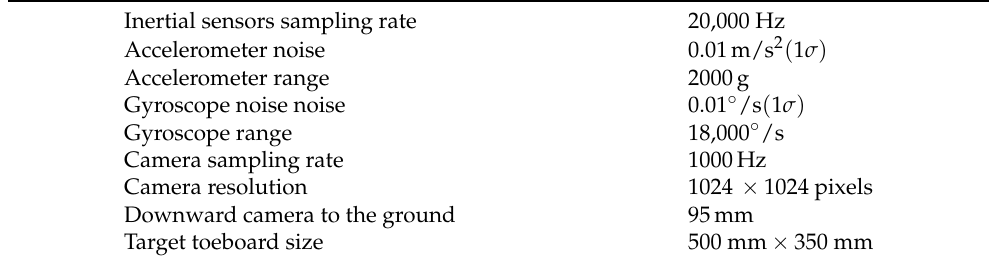
Table 1. Parameters of sensors.